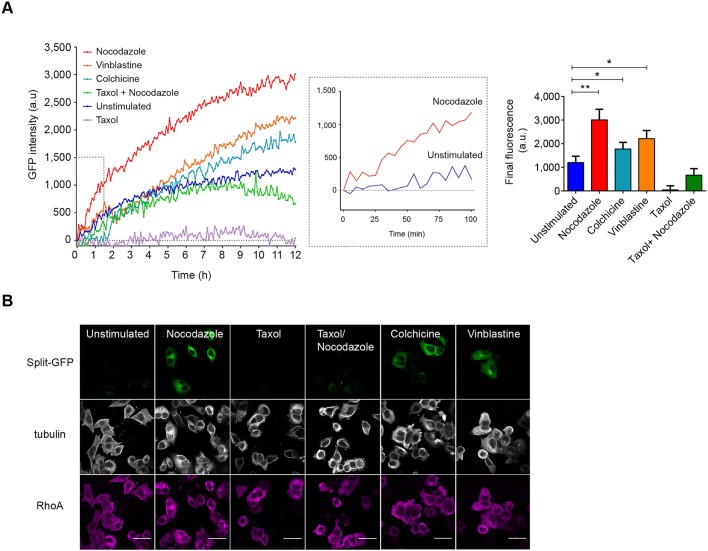
RhoA activation with microtubule drugs. (A) A RhoA activation reporter cell line was engineered to analyze RhoA activation upon treatment with microtubule poisons in a 96-well format. GFP intensity kinetic curves show modulation of RhoA activation upon treatment with indicated compounds (mean of three independent acquisitions). Middle graph, nocodazole shows the strongest induction of GFP fluorescence (y-axis shows arbitrary units), highlighting the increase of split-GFP fluorescence early after stimulation. The bar graph on the right shows the final GFP fluorescence value for each condition. Results are mean±s.e.m.; n=3, *P<0.05, **P<0.01 (Student's t-test). (B) Representative confocal images of split-GFP fluorescence (FITC channel), α-tubulin (gray) and RhoA expression (anti-GFP10, magenta) for the indicated treatments. Scale bars: 40 µm.